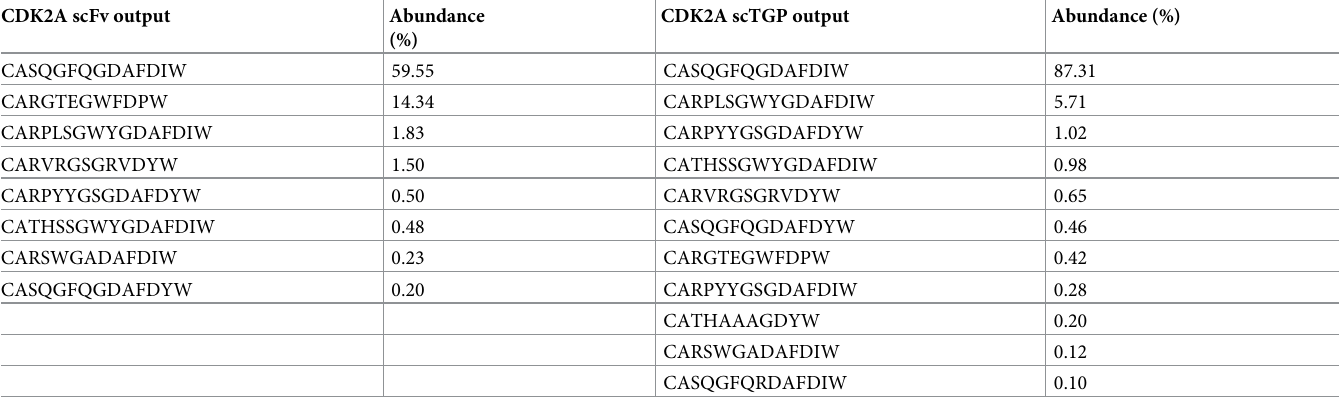
Table 2. VH-CDR3 amino acid sequences of scFv and scTGP clones that recognize CDK2A with relative abundance of each clone in the sorted yeast sub-library. Identical CDRS in both libraries are indicated with same colors. CDK2A scFv